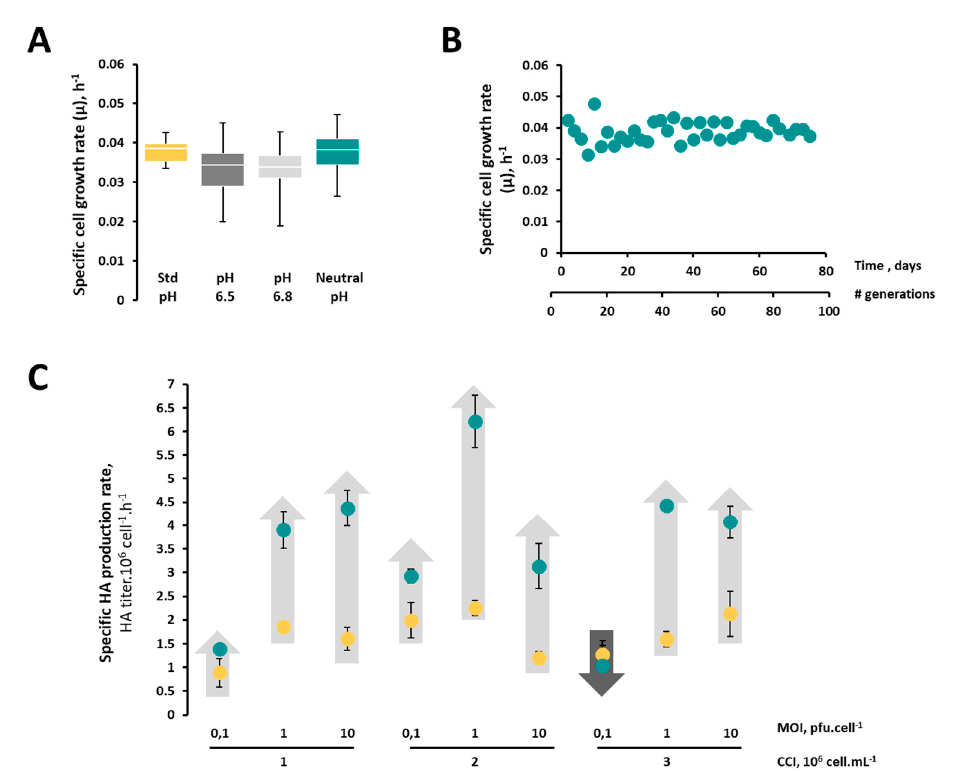
Figure 1. Adaptation of High Five insect cells to neutral culture pH for influenza hemagglutinin (HA)-displaying virus-like particle (VLP) production. ( A ) Box-plot diagrams showing the degree of dispersion and skewness in specific cell growth rate ( µ , h − 1 ) values during the adaptation process; horizontal lines are medians, boxes represent the interquartile range, and error bars show the full range of values. ( B ) Scatter graph representing the variation in growth rate of adapted cells over 100 generations after establishment of master cell bank. ( C ) Specific HA production rate of adapted (green circles) and non-adapted (yellow circles) cells at di ff erent cell concentration at the time of infection (CCI) / multiplicity of infection (MOI) combinations; arrows represent the variation in specific HA production rates from non-adapted to adapted cells, where light grey denotes an increase and dark grey denotes a decrease (cell-specific production rate was calculated as described in M&M section)—data represent one biological replicate (n = 1).